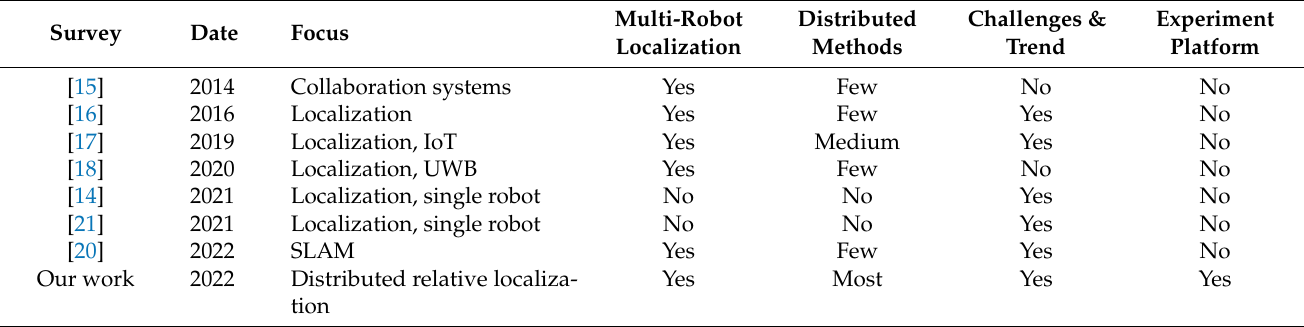
Table 1. Comparison with related